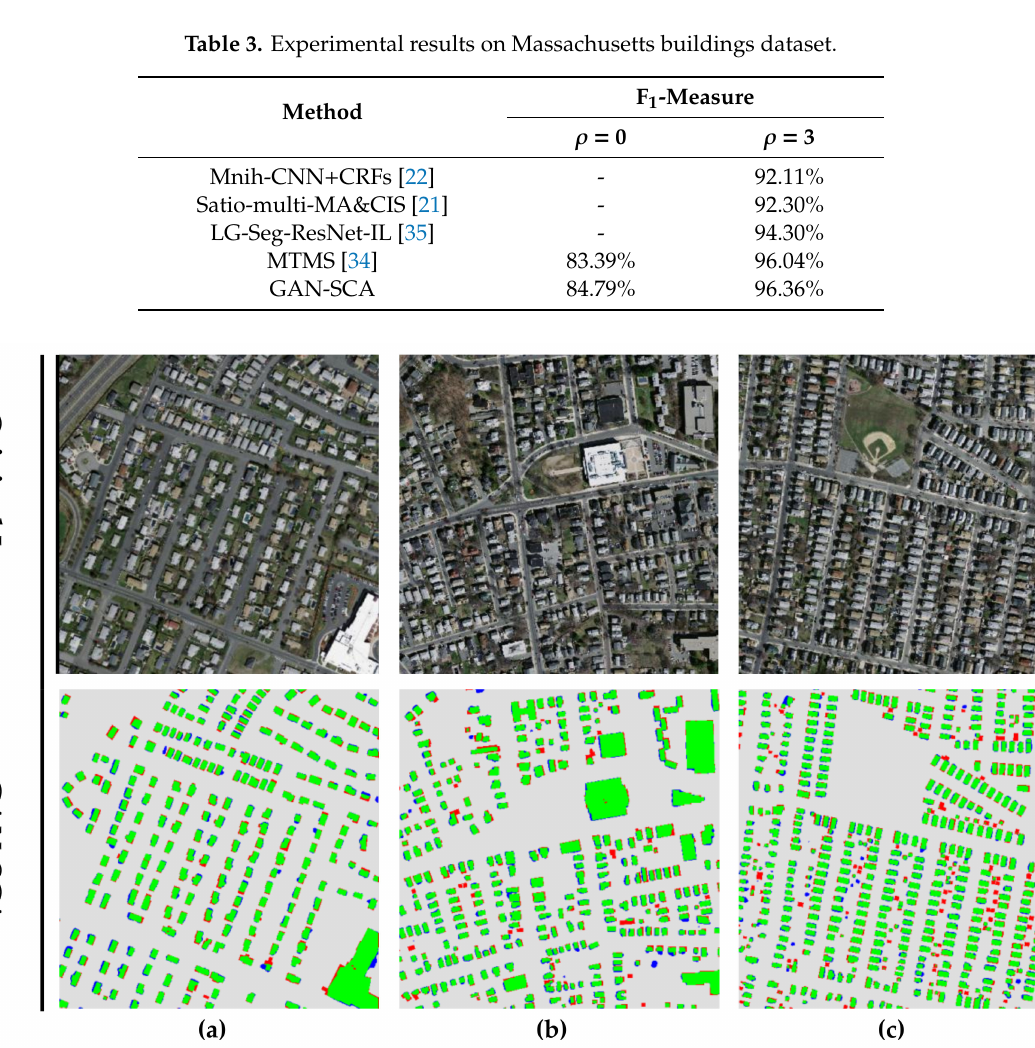
Figure 7. Building extraction results on the Massachusetts buildings dataset. ( a – c ) prediction results of three image patches in Massachusetts buildings dataset. Green: true positive (tp) pixels; Gray: true negative (tn) pixels; Blue: false positive (fp) pixels; Red: false negative (fn)